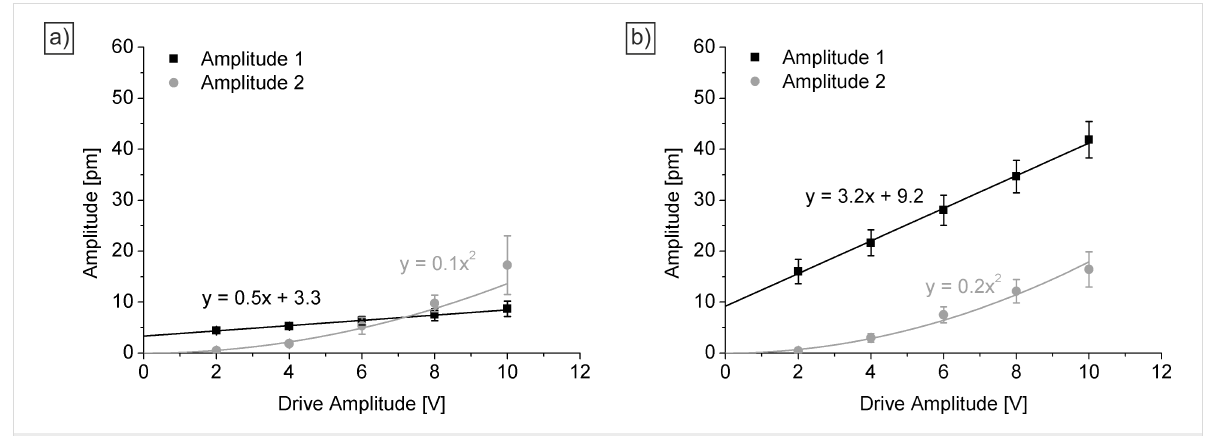
Figure 6: Quantitative analysis of the piezoelectric responses of ZnO films deposited on carboxylate-SAM (a) and PEL